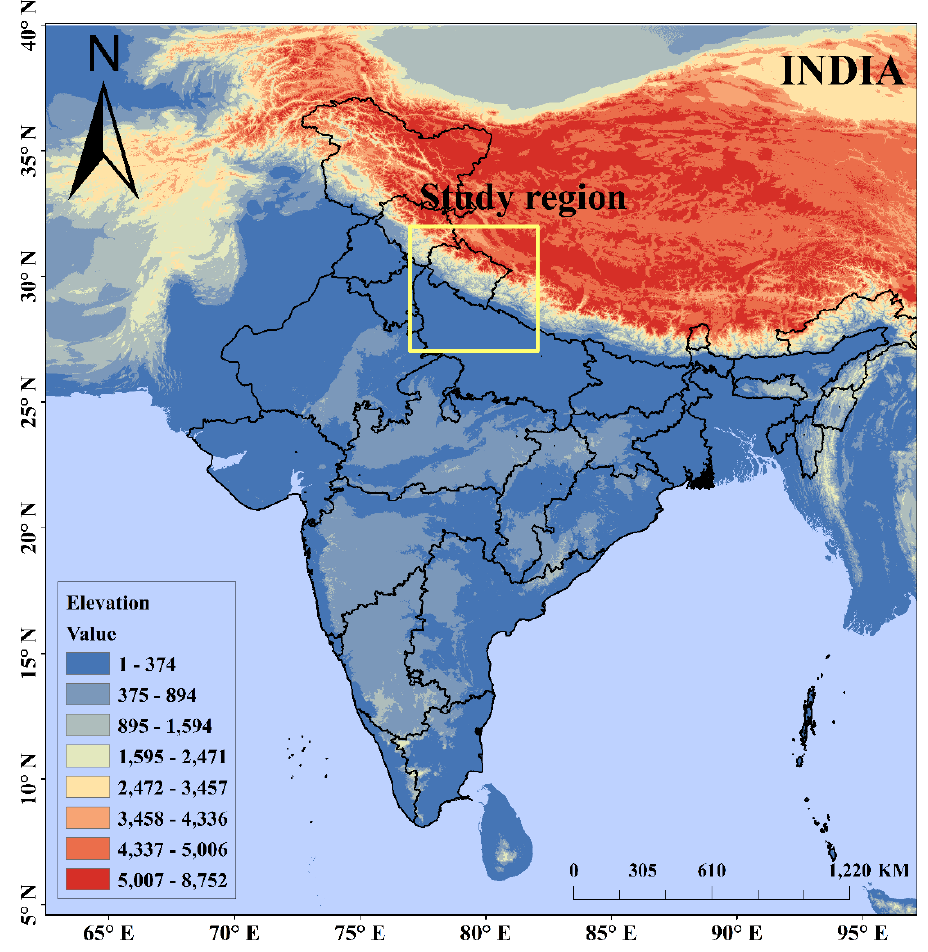
Figure 2. A topography map of the study region over the Indian subcontinent. The data were obtained from United State Geographical Survey (USGS) earth explorer digital elevation models (DEM) data.